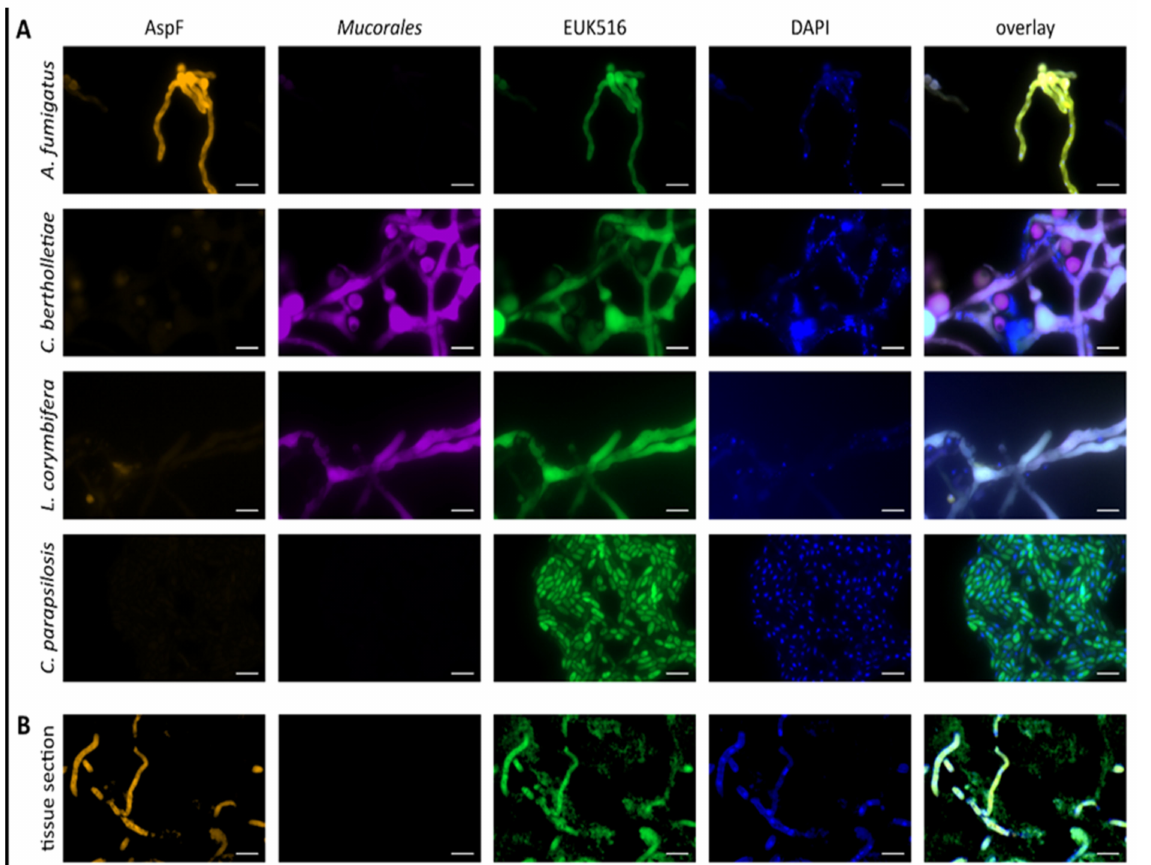
Figure 3. Fungal rRNA FISH of paranasal tissue biopsy and controls. ( A ) Fungi fixed in formalin reveal specific hybridization of probes targeting Aspergillus (AspF, labeled with Cy3, colored orange), the agents of mucormycosis (Mucorales, an equimolar mixture of the probes mucor and Lichtheima labeled with Cy5, colored magenta), and control probes targeting eukaryotic cells (labeled with Alexa fluor488, colored green). Results of nonsense probes are not shown. Counterstaining with DAPI was used to visualize double-stranded DNA in nuclei. ( B ) Hyphal elements of different width hybridizing exclusively with the probe targeting Aspergillus and the unspecific control probe but not the Mucorales probe, suggesting aspergillosis without evidence for concomitant mucormycosis. Note scant fluorescence signal of hyphae in tissue sample in the DAPI channel as compared to controls. Bar represents 10 µ